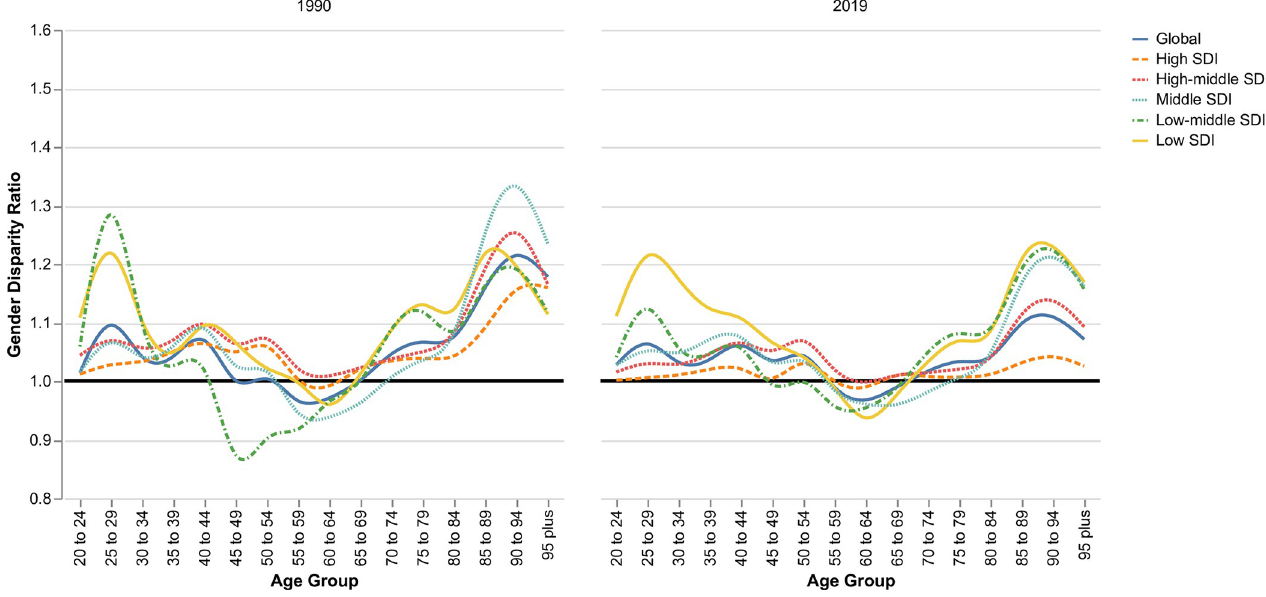
Fig 4. Gender disparity ratio for quality of care index of peptic ulcer disease among age groups and SDI levels in 1990 and 2019.